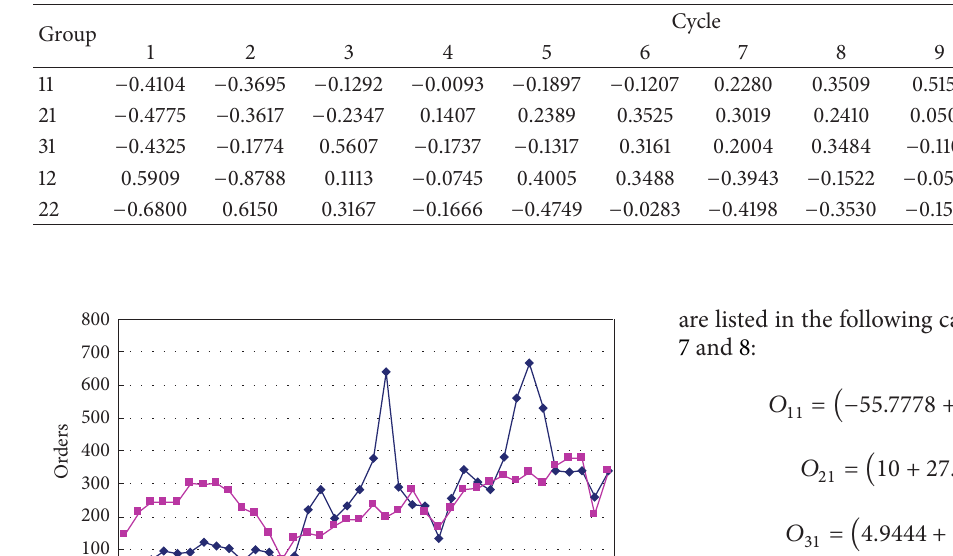
Table 4: The seasonal ratios in the polynomial model.